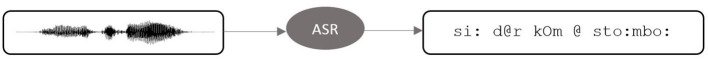
Automatic speech recognition (from audio to transcription).